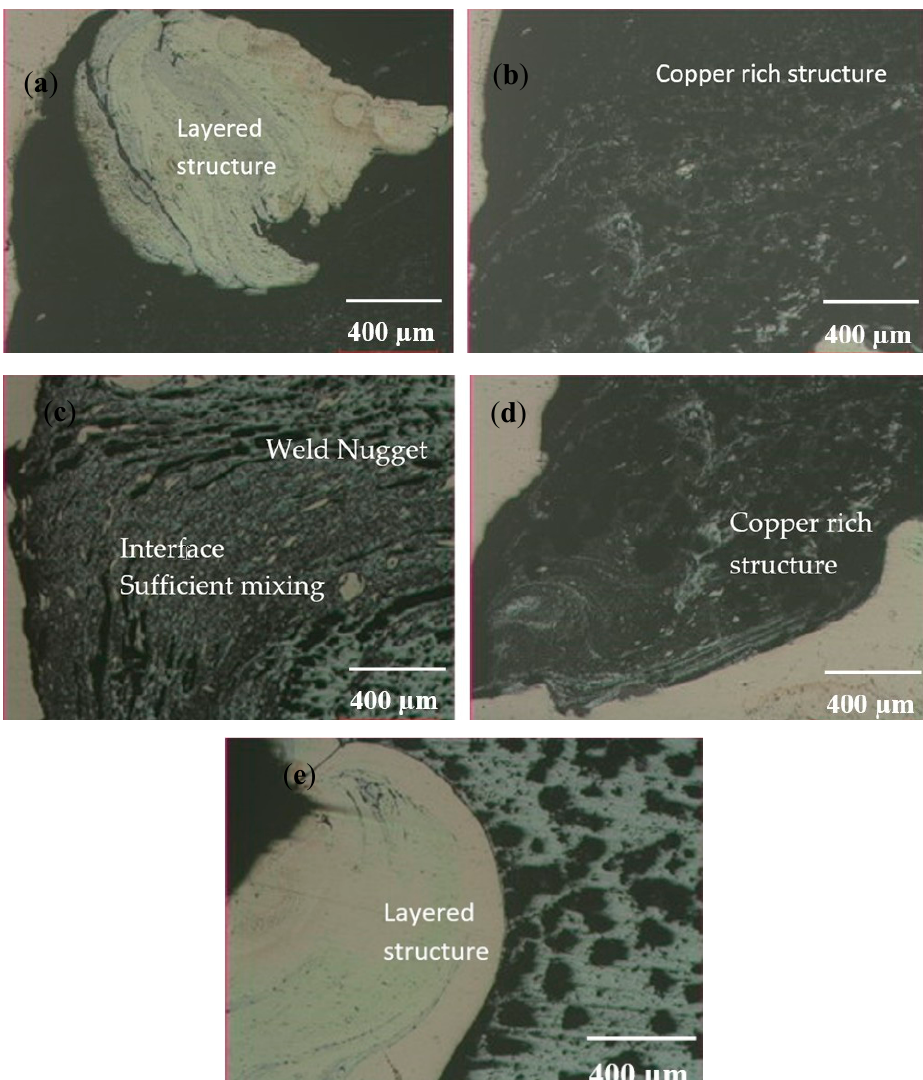
Figure 16. Welded zone of the 630/50/1 specimen: ( a ) Al side; ( b ) Nugget Zone.